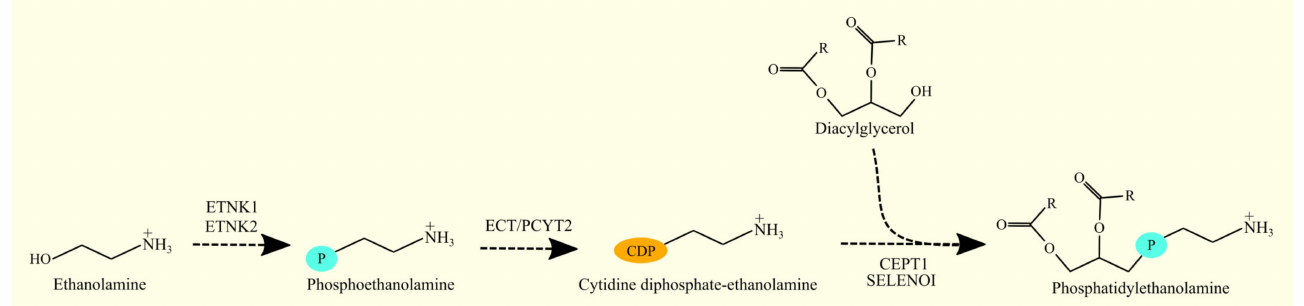
Figure 6. The biosynthesis of PE in the Kennedy pathway. In this pathway, ethanolamine is phospho- rylated and then converted to CDP-ethanolamine. In the final step, CDP-ethanolamine reacts with DAG to produce PE. The enzymes responsible for these reactions are CEPT1 and